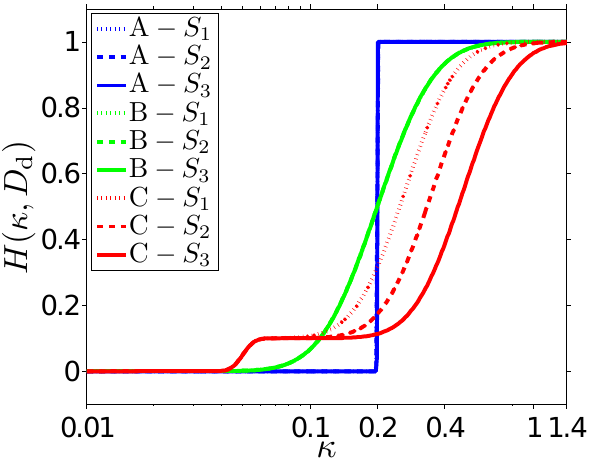
Fig. 5. Cumulative particle hygroscopicity distributions, H(κ,D d ) , calculated from the CCN efficiency spectra of hypothetical case study aerosols (Fig. 3). Each line represents the cumulative dis- tribution of one type of model aerosol (Case A, B, or C, as speci- fied in Table 1 and Fig. 4) at a fixed supersaturation S ( S 1 = 0.86%, S 2 = 0.26%, S 3 = 0.067%). The three blue (or green) lines at differ- ent S converge into a single curve.